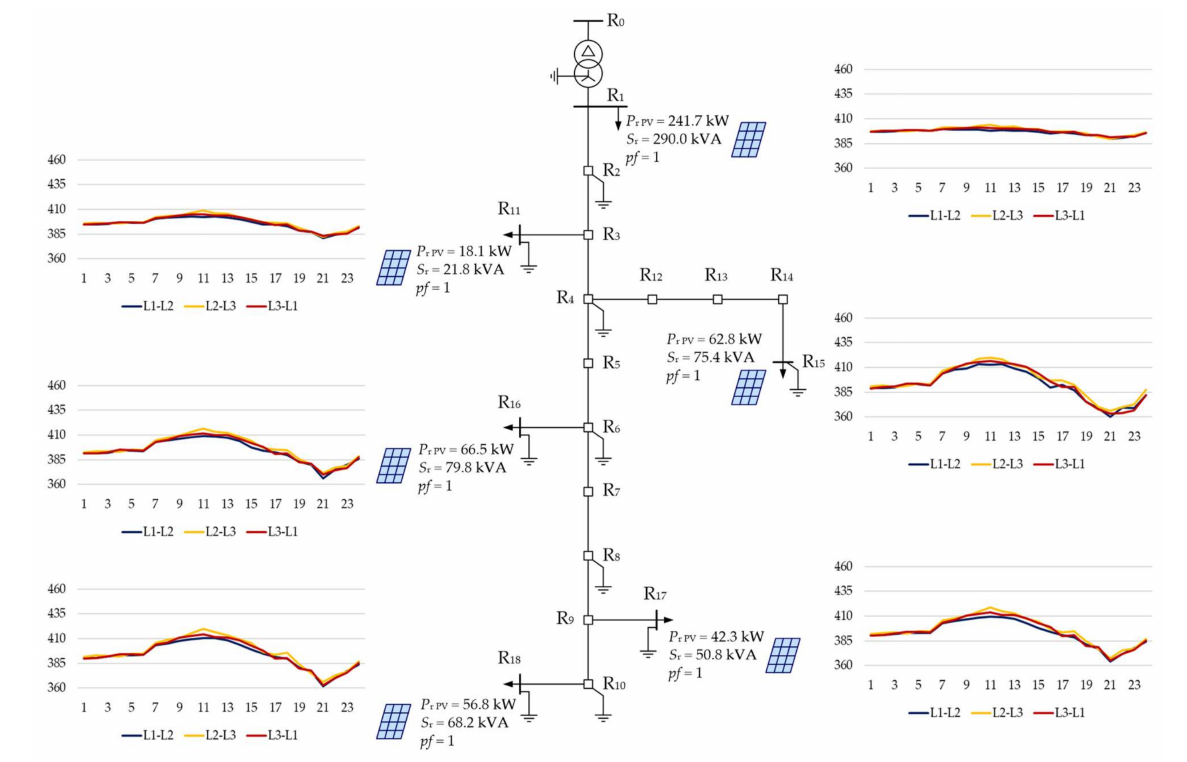
Figure A11. Daily simulation results for variant V9: phase-to-phase voltages (V).